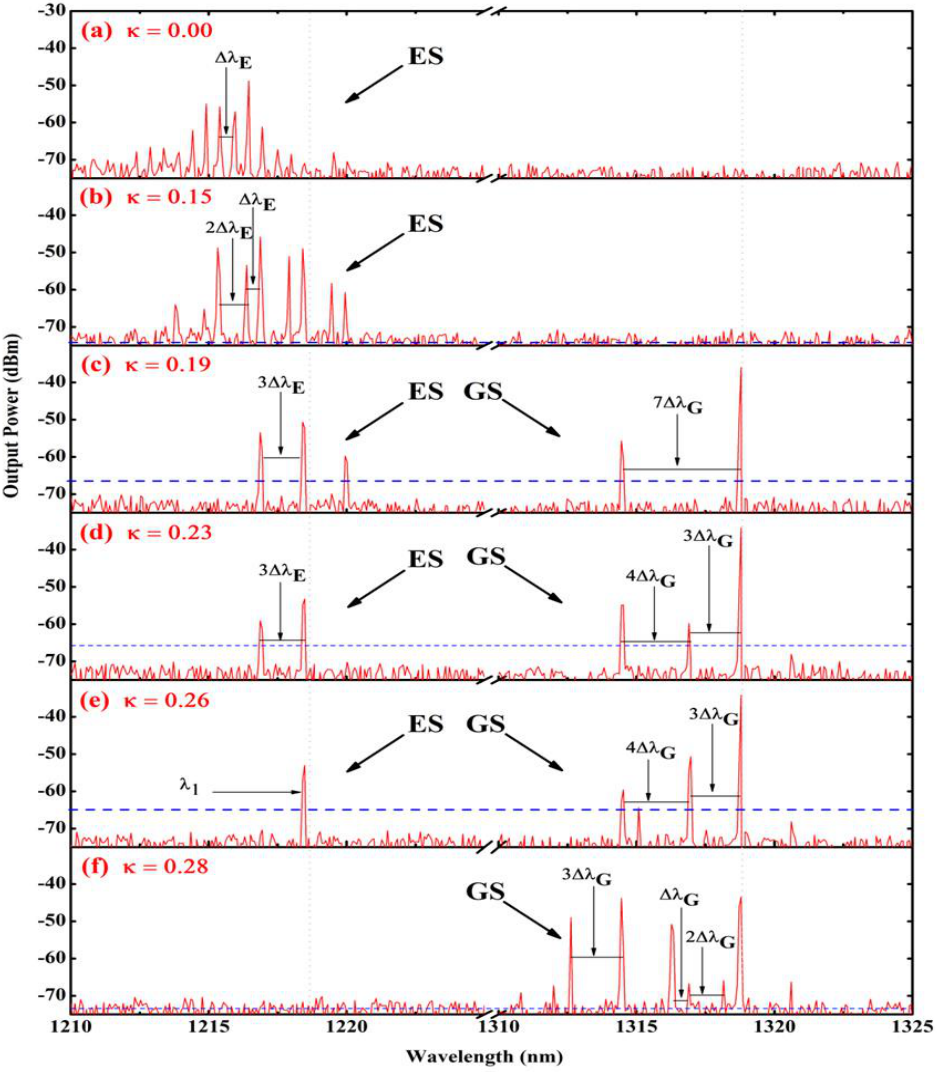
Figure 3. Optical spectra of ESQDL biased at 70.40 mA under concave mirror optical feedback with different feedback strength.